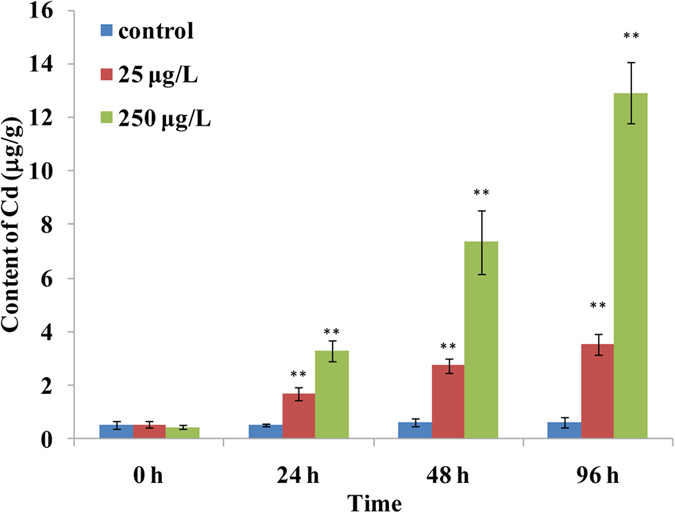
The accumulated concentrations (μg/g) of cadmium (Cd) in the gills from blood clams Tegillarca granosa after exposure to Cd for 24, 48 and 96 hours.The cadmium concentrations were presented as the mean ± standard deviation. The significance of the difference (**p < 0.01) between control and Cd treated-groups was tested by a one-way analysis of variance.